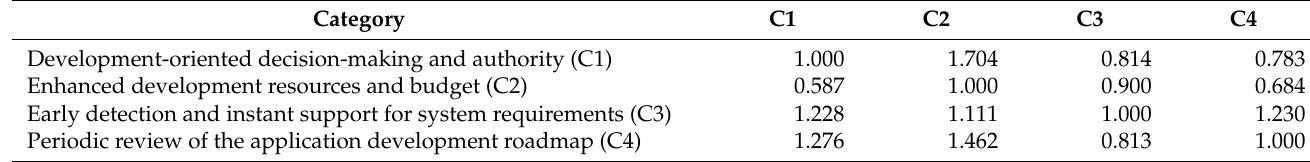
Table 8. Consolidated decision matrix for D1